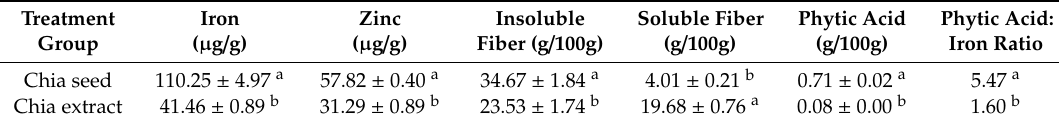
Table 2. Concentration of iron, zinc, dietary fiber and phytic acid in chia flour and in chia